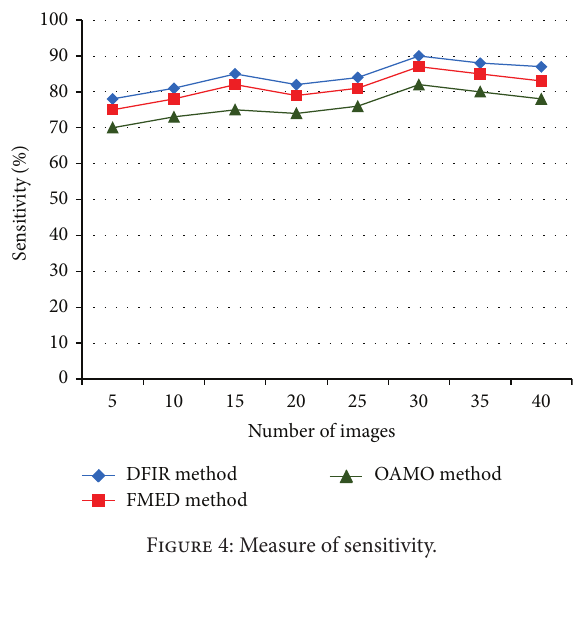
Figure 4: Measure of sensitivity.